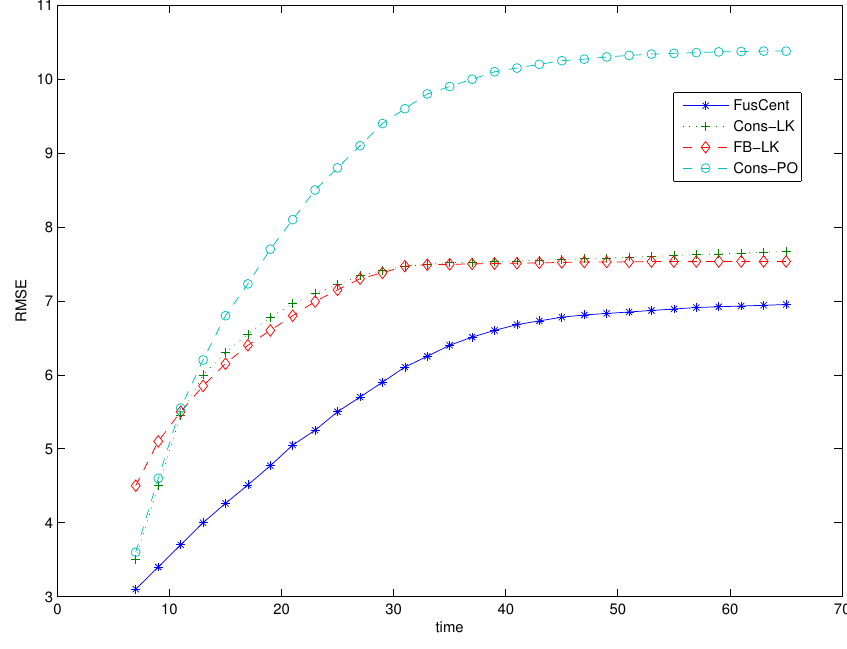
Figure 2. Root Mean Square Error (RMSE) versus